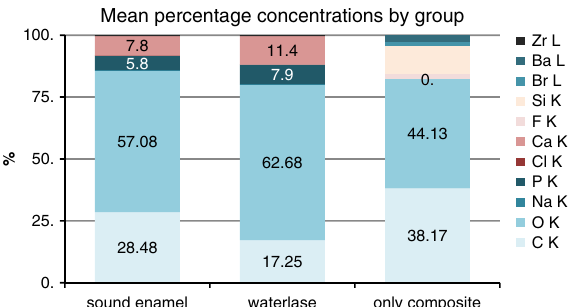
Figure 1. Mean percentage concentrations by group.